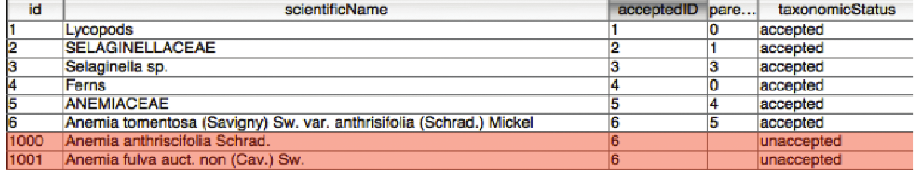
Figure 6. Synonym records (highlighted) added and